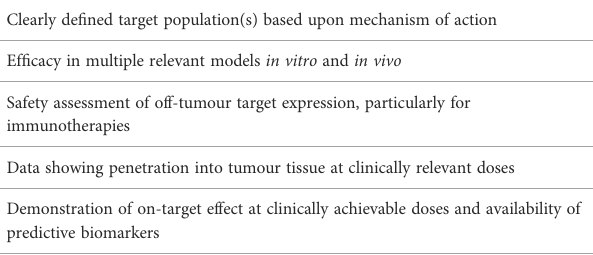
TABLE 1 Principles of preclinical assessment . Clearly de fi ned target population(s) based upon mechanism of action Ef fi cacy in multiple relevant models in vitro and in vivo Safety assessment of off-tumour target expression, particularly for immunotherapies Data showing penetration into tumour tissue at clinically relevant doses Demonstration of on-target effect at clinically achievable doses and availability of predictive biomarkers Guidelines for consideration of a preclinical data package for clinical